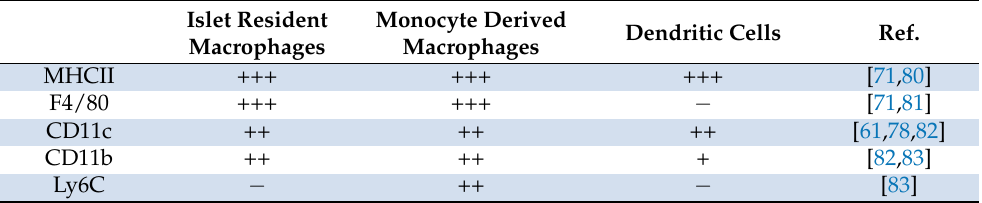
Table 1. Macrophage-specific surface markers and their expression in self-renewing islet-resident macrophages, circulating monocyte-derived macrophages and dendritic cells in pancreatic islets. Islet Resident Monocyte Derived Dendritic Cells Ref. Macrophages Macrophages MHCII +++ +++ +++ [71,80] F4/80 +++ +++ − [71,81] CD11c ++ ++ ++ [61,78,82] CD11b ++ ++ + [82,83] Ly6C − ++ −